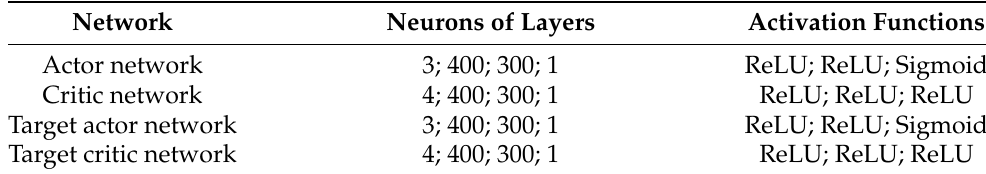
Table 1. Network structures of the implemented artificial neural